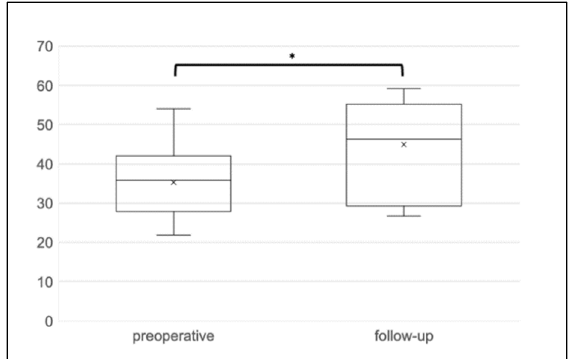
Figure 3. Short-Form-Health survey. The Short-Form-Health survey has increased in the follow-up significantly (35.9 vs. 46.3, p = 0.028). * = significant; x = mean.